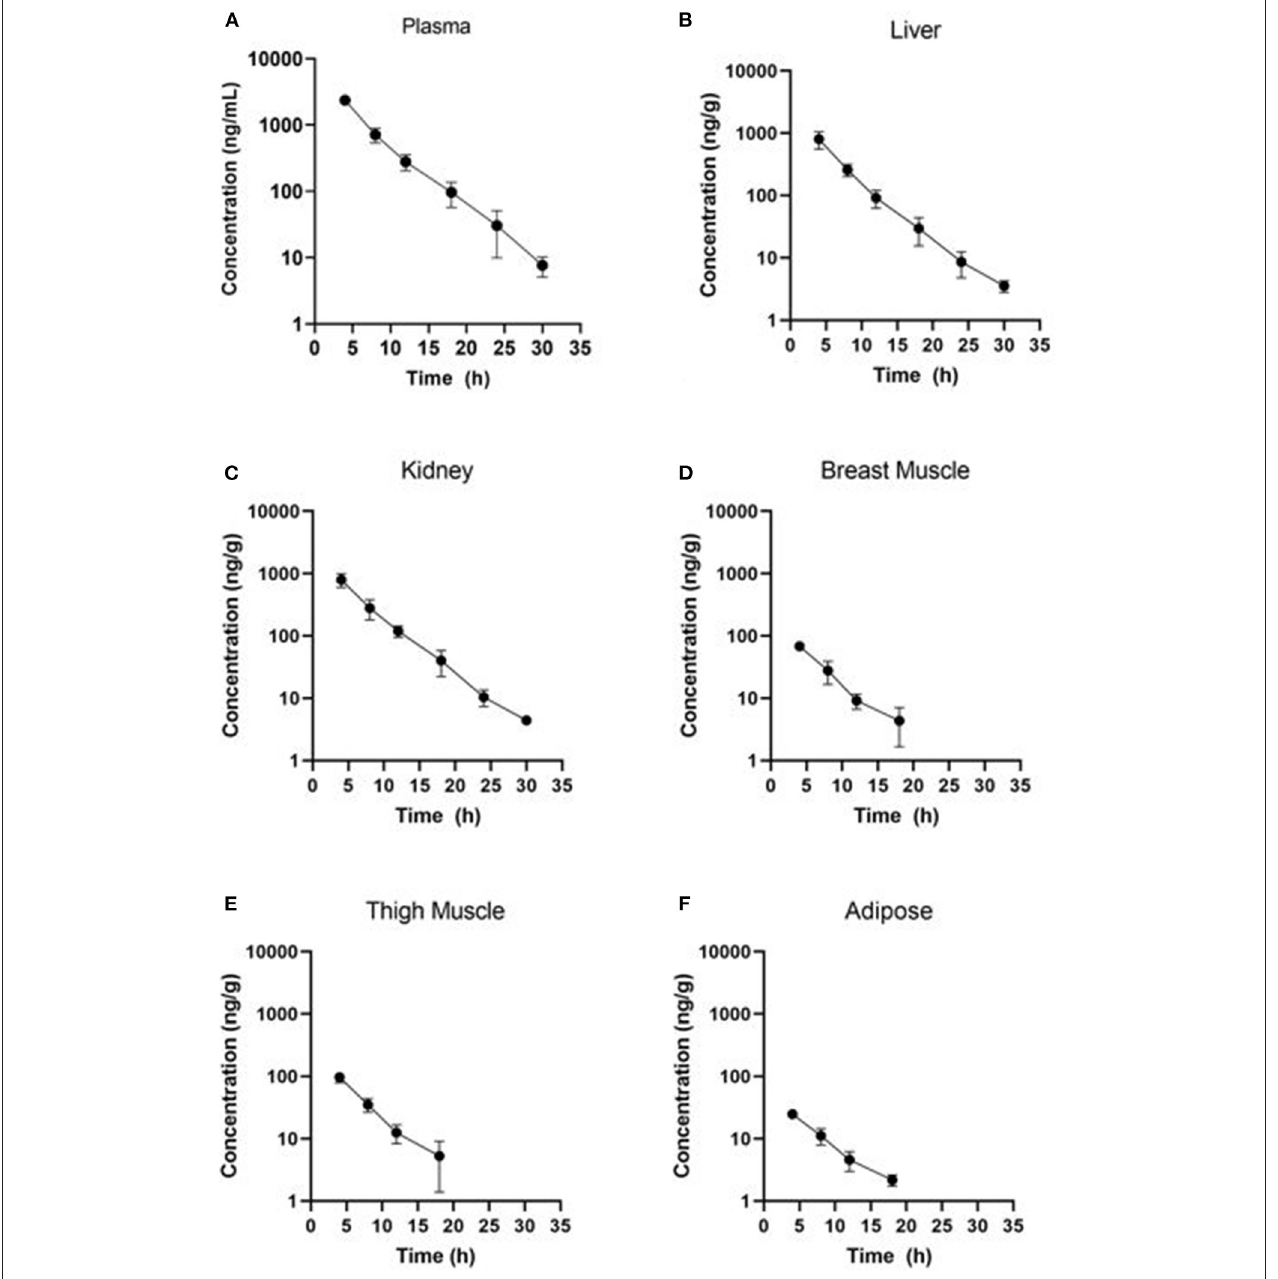
FIGURE 3 | Concentration vs. time curves for tissues collected at slaughter during the IV residue depletion investigation: (A) plasma, (B) liver, (C) kidney, (D) breast muscle, (E) thigh muscle, and (F) adipose. Samples collected from breast muscle, thigh muscle and adipose were below LOD at the 24 and 30h post-treatment sampling